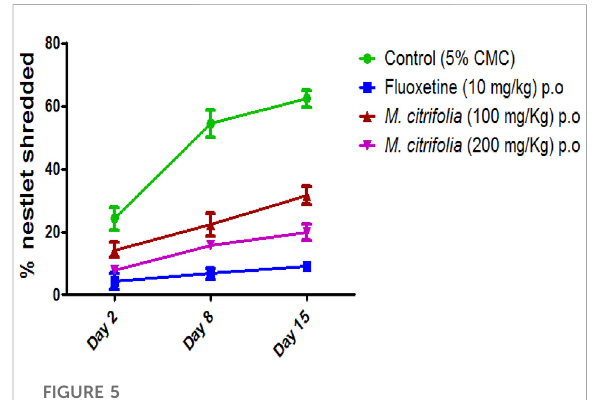
FIGURE 5 In vivo evaluation of nestlet shredding test of MCFE.